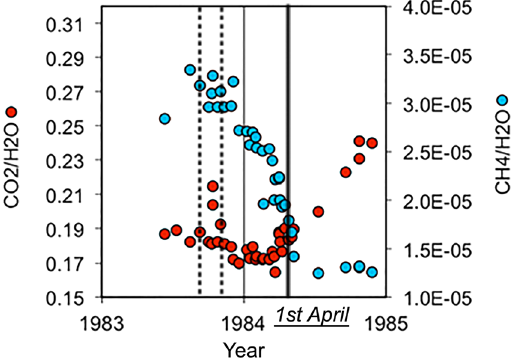
Figure 2. Geochemical gas composition during unrest. CO 2 / H 2 O (left, red dots) and CH 4 / H 2 O (right, blue dots) ratios measurements against time. April 1, when the decrease of CH 4 / H 2 O stops and the increase of CO 2 / H 2 O starts, is marked by a black bar. September-October 1983 (between the vertical dashed lines) corresponds to the period when fluid injections are perturbing the upper hydrothermal system at Solfatara, following the fluid-flow modelling of Chiodini et al . 17 . The plot is obtained using the plotting functions of Microsoft Excel © for Mac 2011 14.4.9 (https://www.microsoft.com/en-us/download/details.aspx?id =